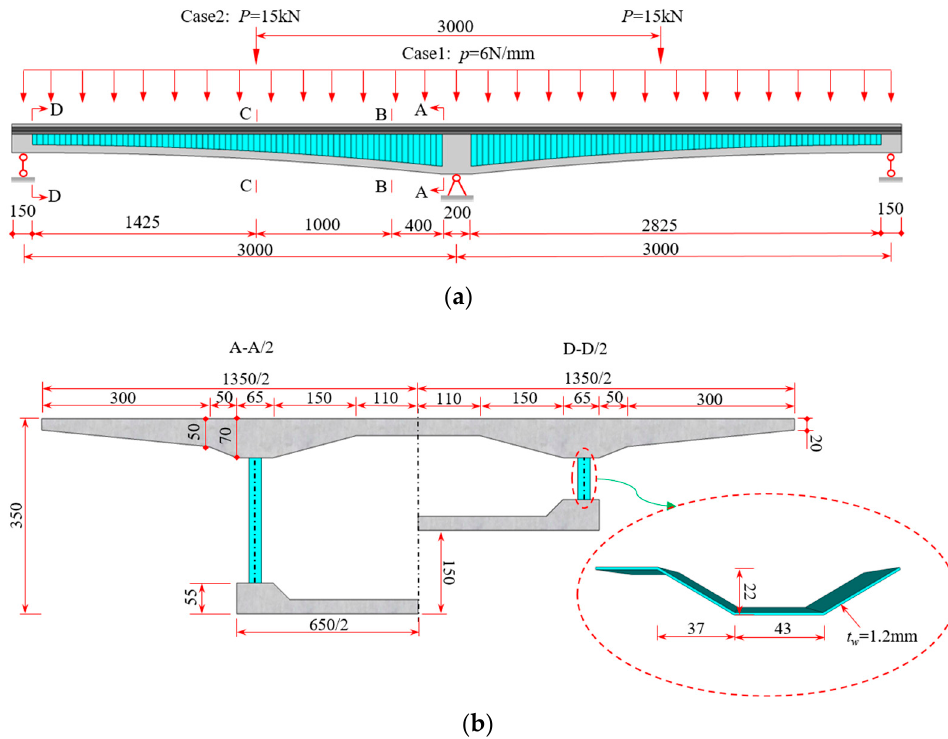
Figure 16. Two-span continuous CBG-CSWs (unit: mm): ( a ) load cases layout; ( b ) cross-section. Considering the corner haunch of concrete flanges in actual bridge construction, when calculating the cross-section parameters, the center lines of upper and lower concrete flanges are selected as the centroid of each flange to obtain h u and h l . When the beam segment element program is used for analysis, the calculated span of the whole bridge is divided into 60 equal-length elements along the beam axis. The variable section beam